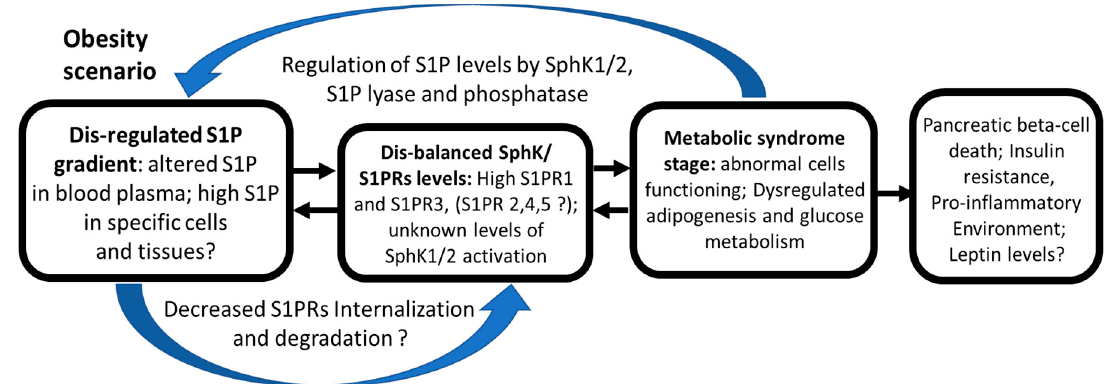
Figure 3. Obesity scenario: transformation and/or adaptation of sphingolipid signaling under condition of metabolic stress (hypothetical scheme). Sphingolipid signaling pathway was proposed to alter during metabolic stress in obese organisms. Blood plasma of obese patients was characterized by dis-regulated S1P gradient, decreased levels of S1P in blood plasma, but higher S1P in specific cells and tissues [102,107,209,210]. Higher S1PR1 and S1PR3 levels were also detected [68]. However, these findings require further confirmation. Black arrows indicate directions of S1P/S1PRs effects. Question marks indicate the gaps in our knowledge of SphK/S1P/S1PRs axis.